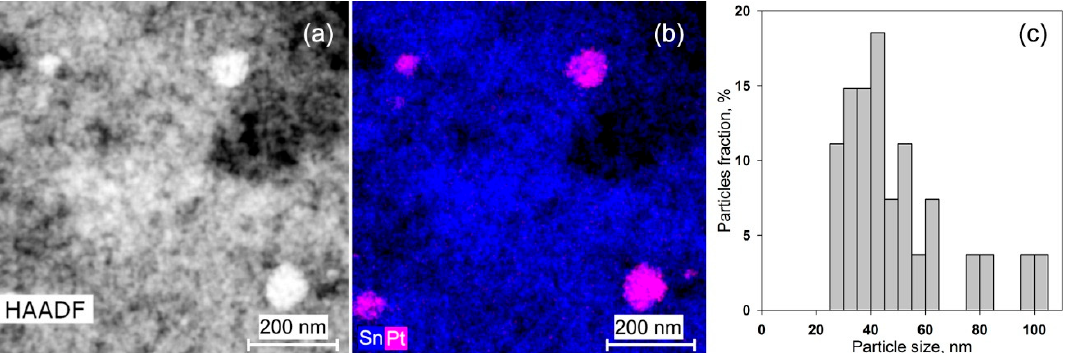
Figure 5. HAADF-STEM image: ( a ) energy dispersive X-ray scanning transmission electron microscopy (EDX-STEM) map ( b ) of the SnO 2 /Pd nanocomposite.